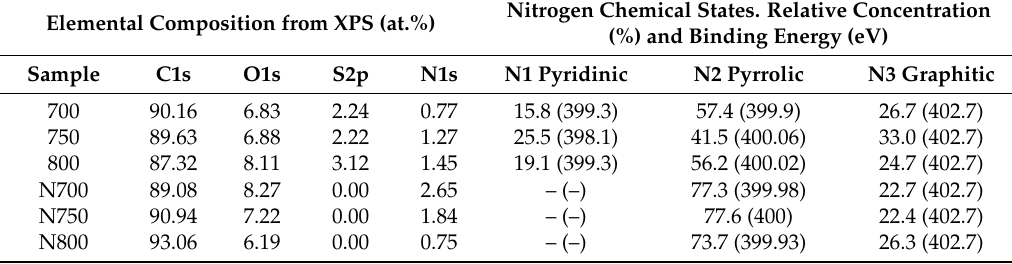
Table 4. X-ray photoelectron spectroscopy (XPS) data of the chemical surface composition of electrocatalysts before (700, 750, and 800) and after C 5 H 5 N doping (N700, N750, and N800). Elemental Composition from XPS (at.%)